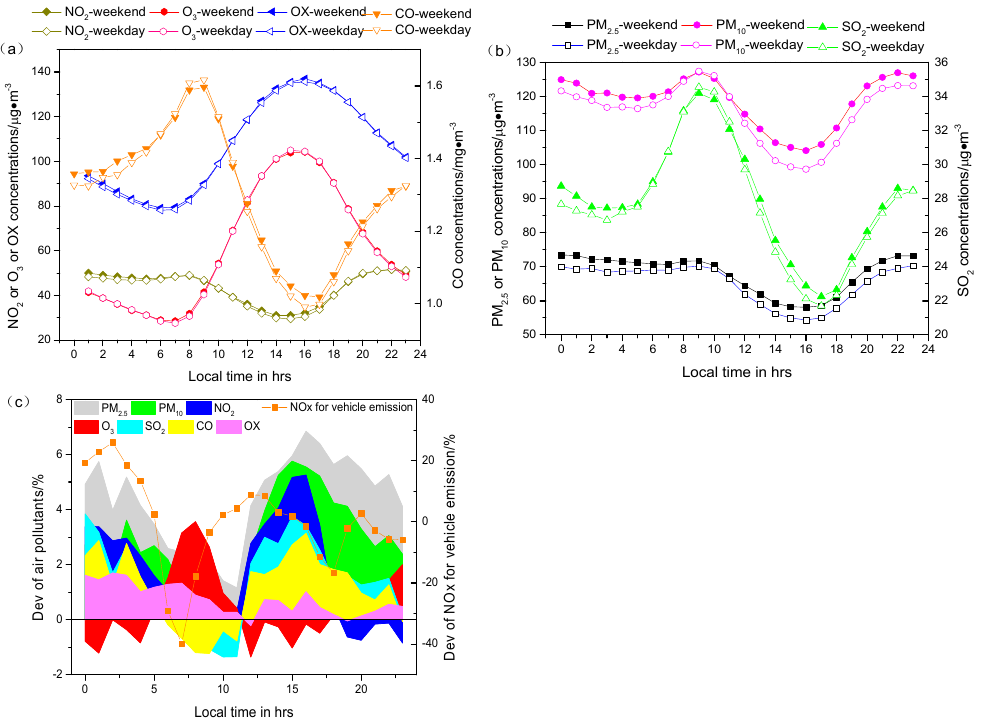
Figure 7. Diurnal variation of O 3 and other pollutant concentrations on weekends and weekdays ( a – c ) deviations of pollutant concentrations between weekday and weekend (the deviations of NOx for vehicle emissions were calculated based on the data from Jing et al. [59] and Song et al. [53]).